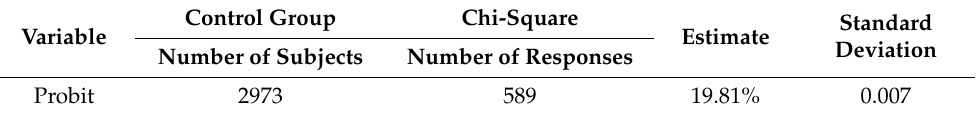
Table 8. Estimate of Respond